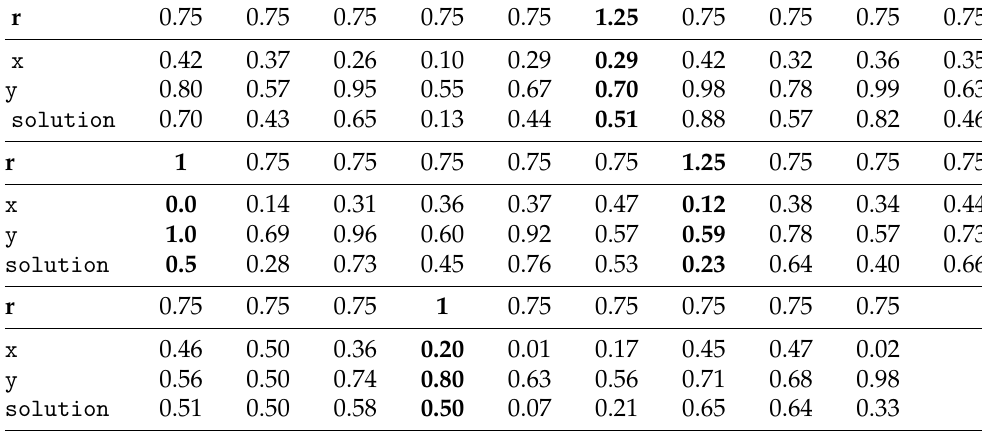
Table 2. Data for parameter learning of the averaging function inclined to the class no